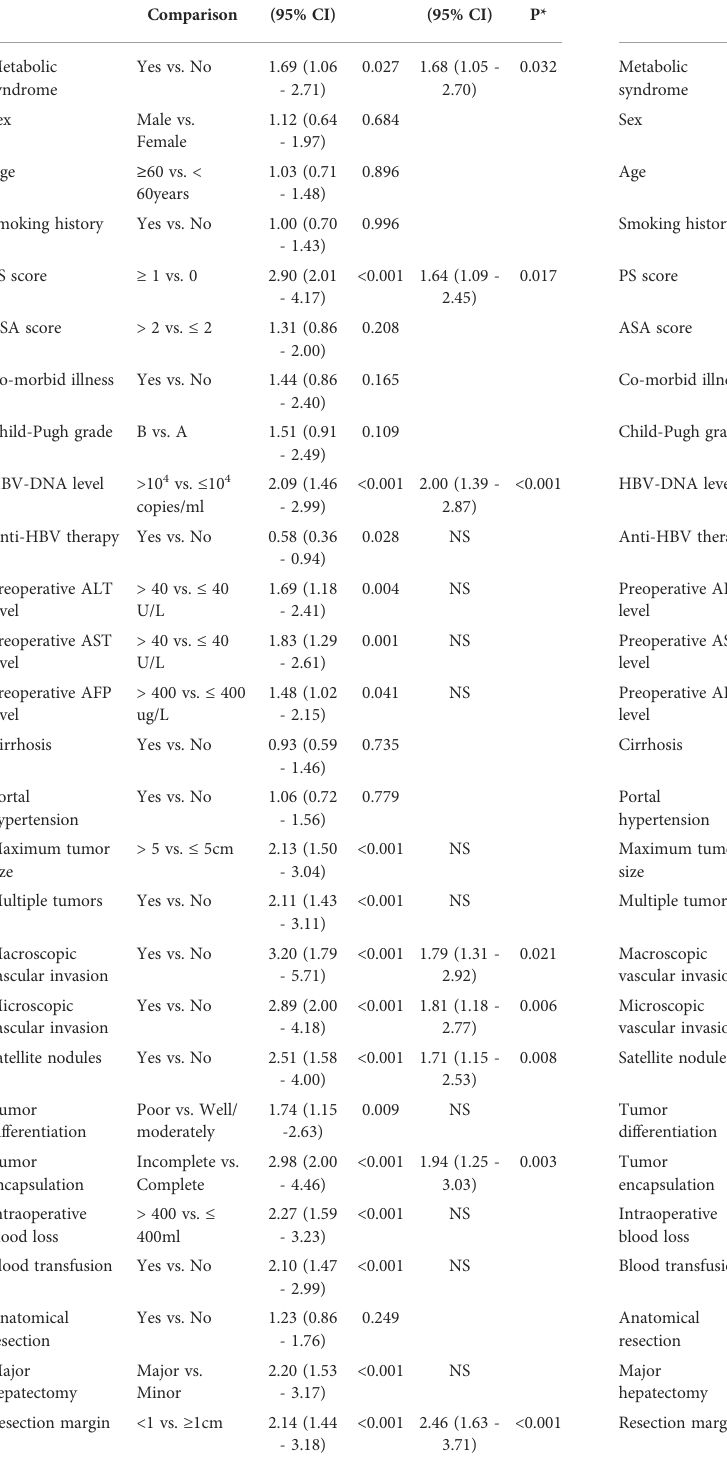
TABLE 4 Univariable and multivariable Cox regression analyses on risk factors of recurrence-free